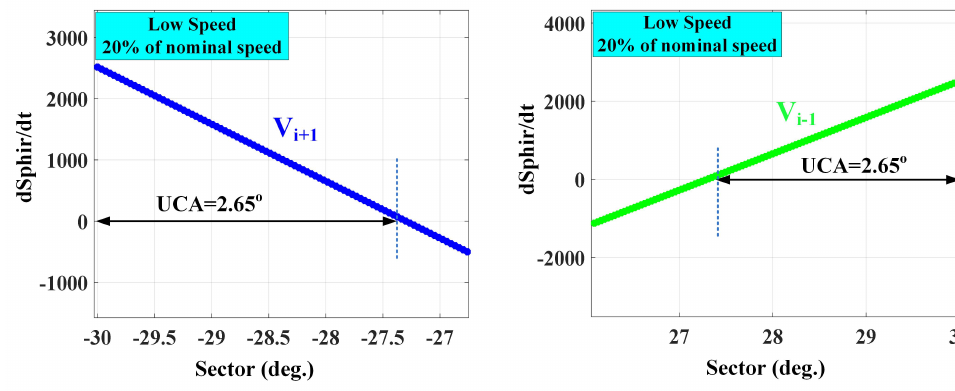
Figure 4. UCA of V i + 1 or V i − 1 on dS Φ r for low speed ( 20% ω n ) .